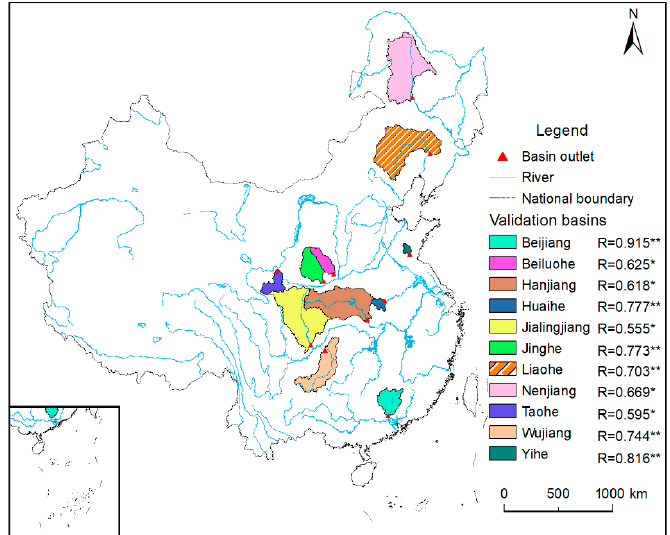
Figure 2. Spatial distributions of the eleven sub-basins for validation. R represents the correlation coefficients between WP and runoff in each sub ‐ basin. The double asterisk (**) indicates that the significance level of correlation coefficient (R) is less than 0.01 and the asterisk (*) represents the significance level of R is greater than 0.01 and less than 0.05.